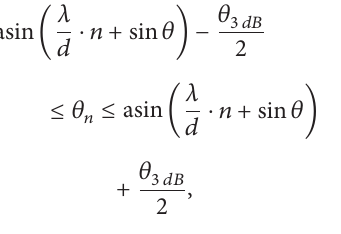
where 𝑉 is the equivalent velocity, 𝜃 represents the steering angle, 𝜆 is the wavelength of the signal, 𝜃 3𝑑𝐵 accounts for the antenna beam width in azimuth, and 𝑚 is the number of ambiguous